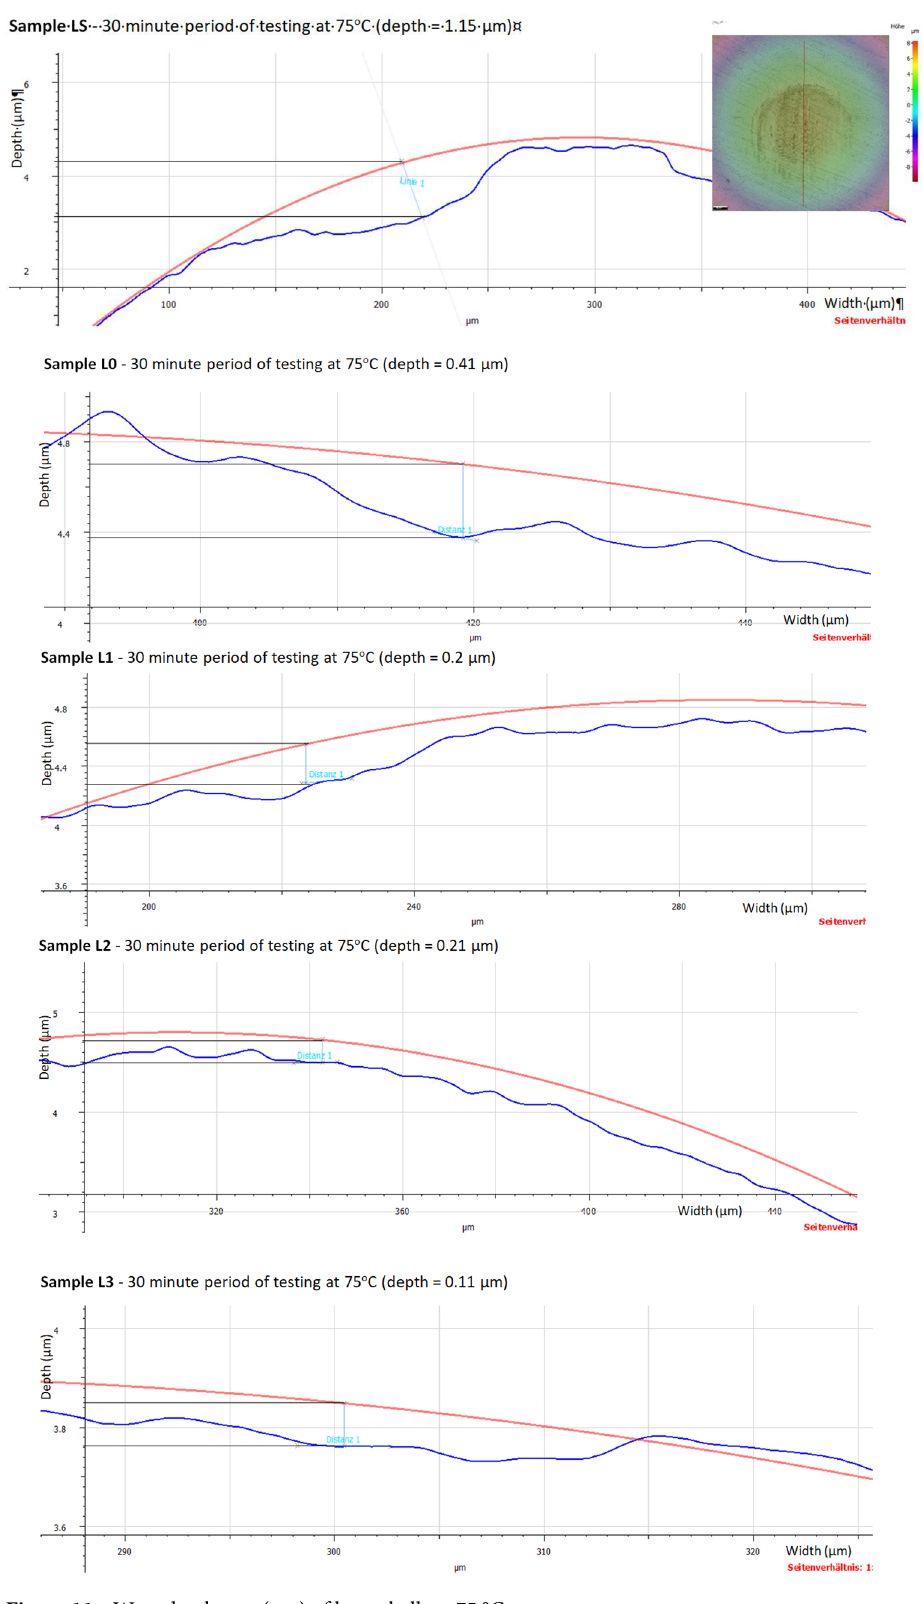
Figure 11. Wear depth scar (µm) of lower balls at 75